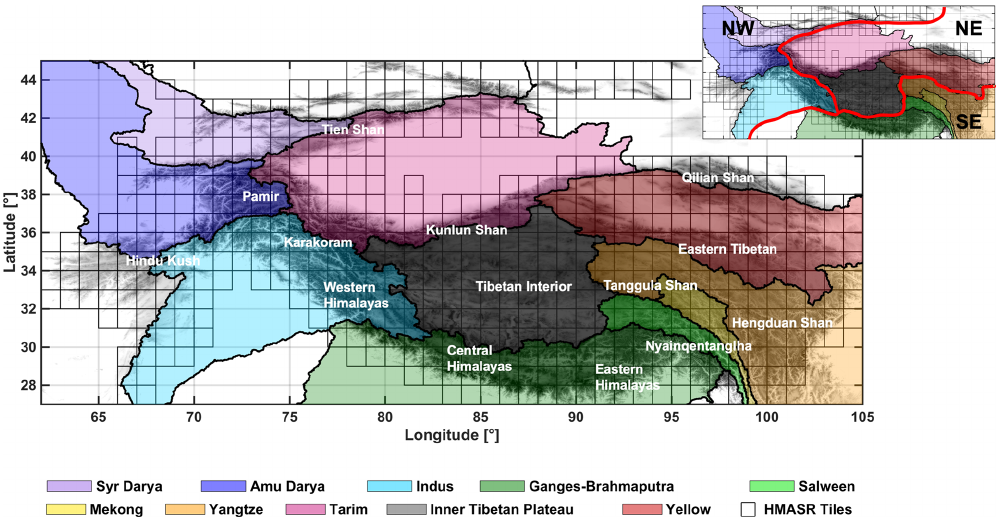
Figure 1. Map of HMA domain with HMASR tiles marked with black boxes. Major watersheds are delineated and colored on the map based on HydroSHEDS (Lehner et al., 2008). Major mountain ranges are labeled with reference to Bolch et al. (2019). A division of the HMA domain into northwestern (NW), northeastern (NE) and southeastern (SE) subregions, which are used for descriptive purposes in this study, is shown in the